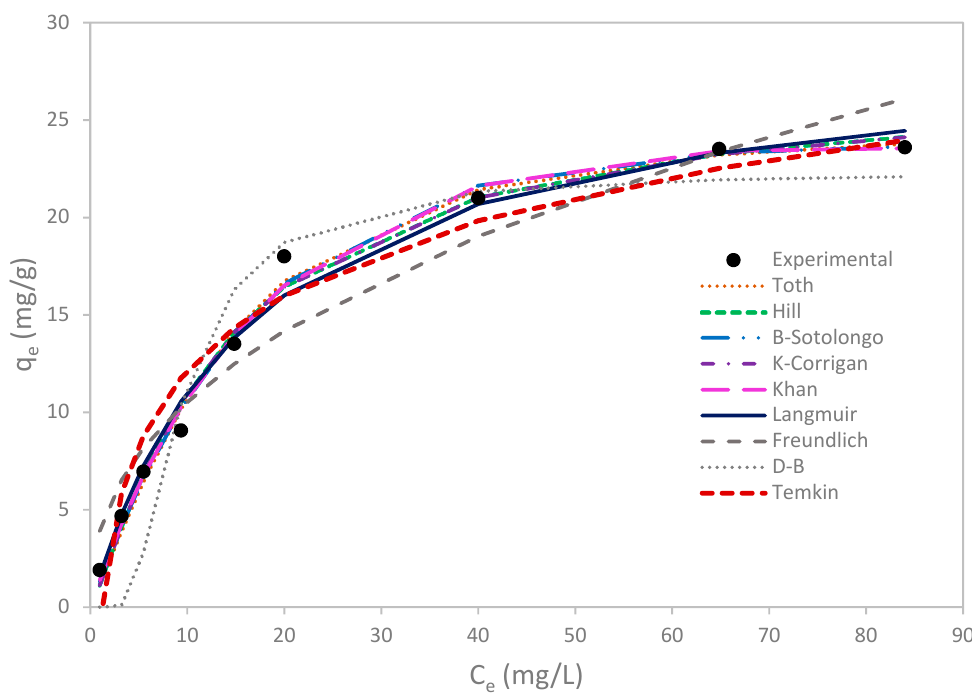
Figure 8. Experimental and theoretical isotherms of copper removal by olive mill solid residues. Table 7. Copper adsorption onto olive pomace at equilibrium and their fitting by two-parameter and three-parameter models.